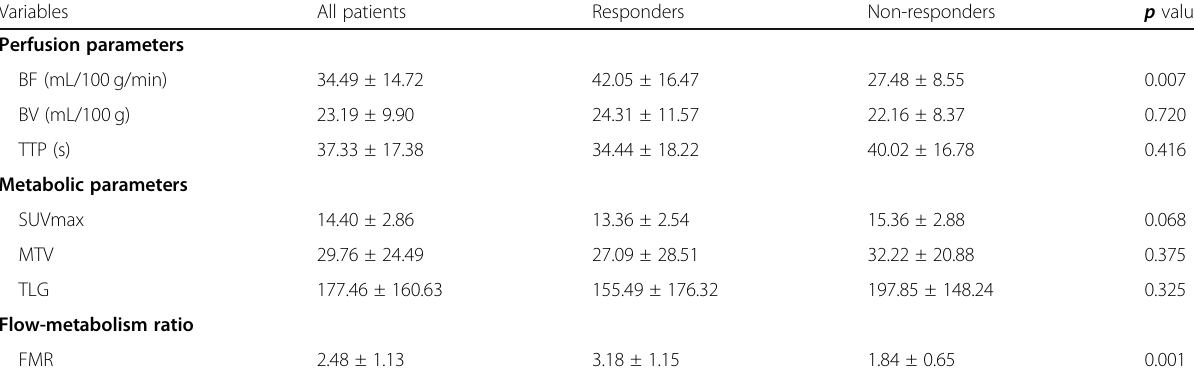
Table 3 Perfusion and metabolic parameters between responders and non-responders Variables All patients Responders Non-responders p value Perfusion parameters